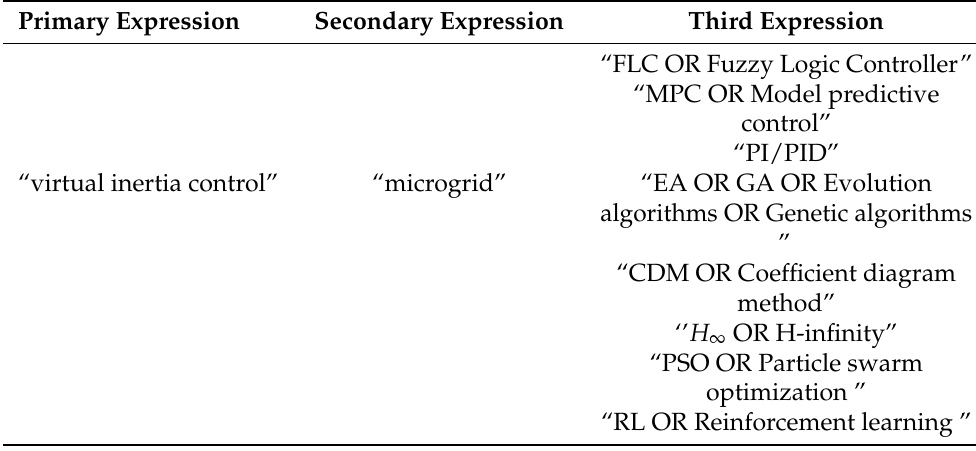
Table 3. Search expressions that were used in the literature